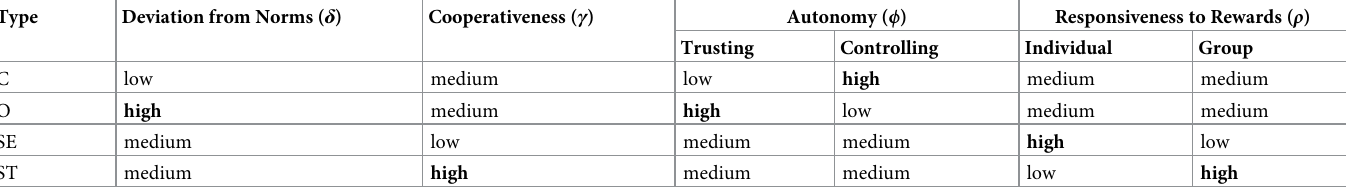
Table 1. Value types and